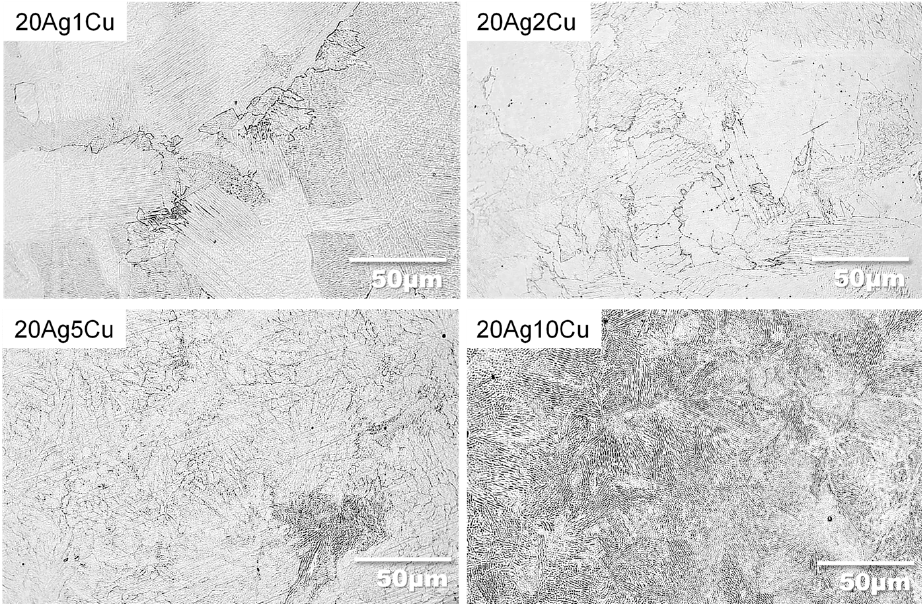
Figure 3. Microstructures of the etched Ti-Ag-Cu